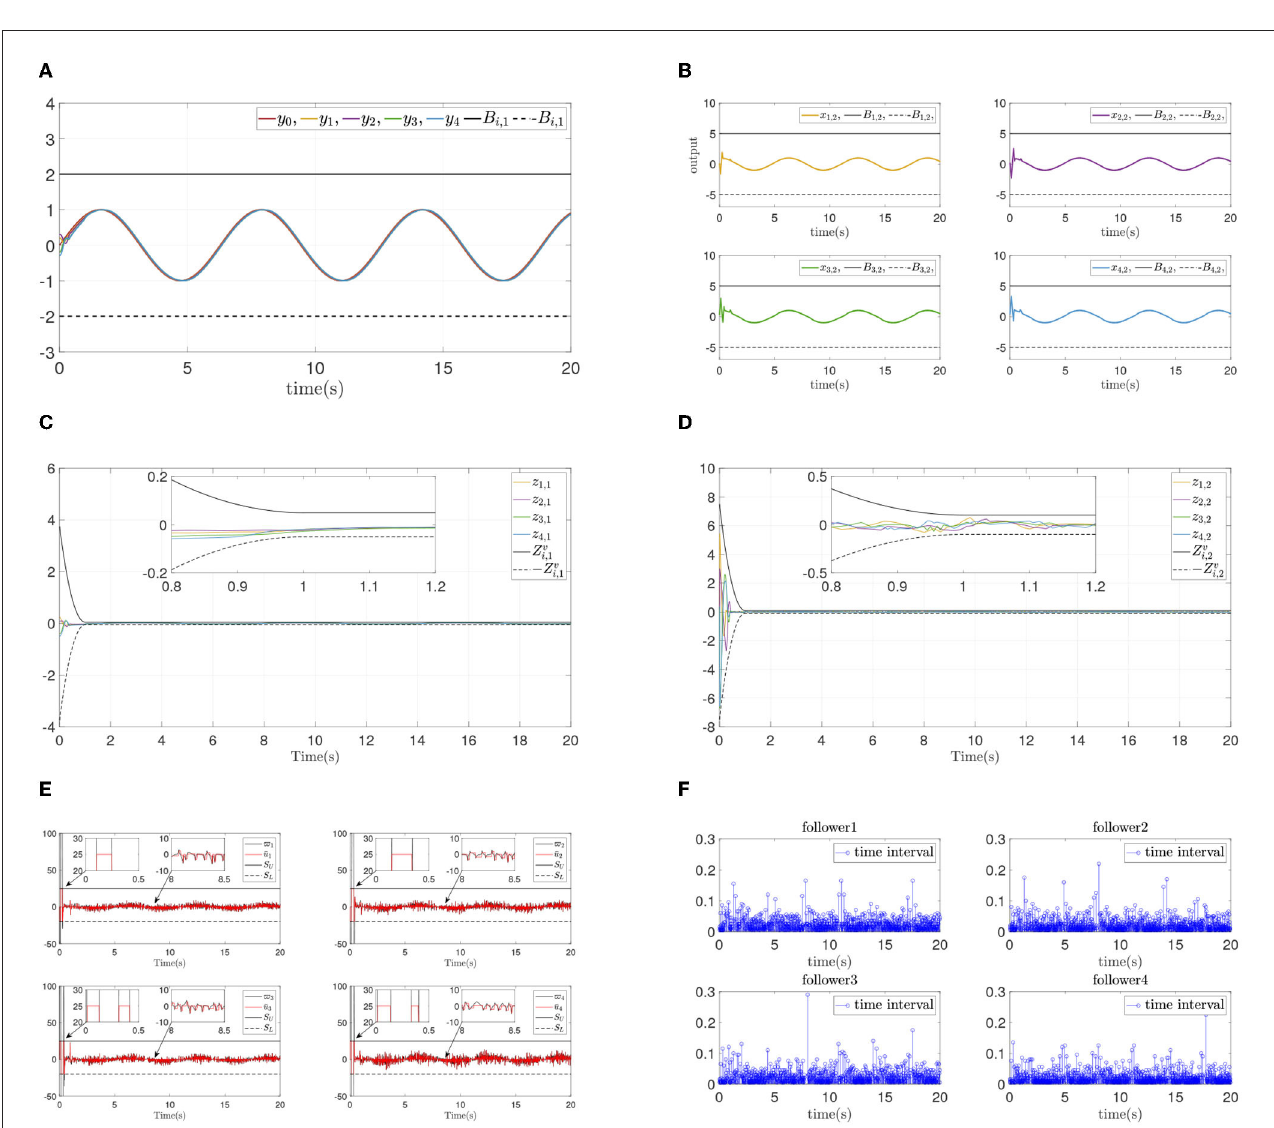
FIGURE6 Simulation results of Example B case I. (A) Followers’ outputs y i . (B) Followers’ states x i ,2 . (C) Synchronization error z i ,1 . (D) Dynamics error z i ,2 . (E) systems input ¯ u i and event-triggered input ̟ i . (F) Time